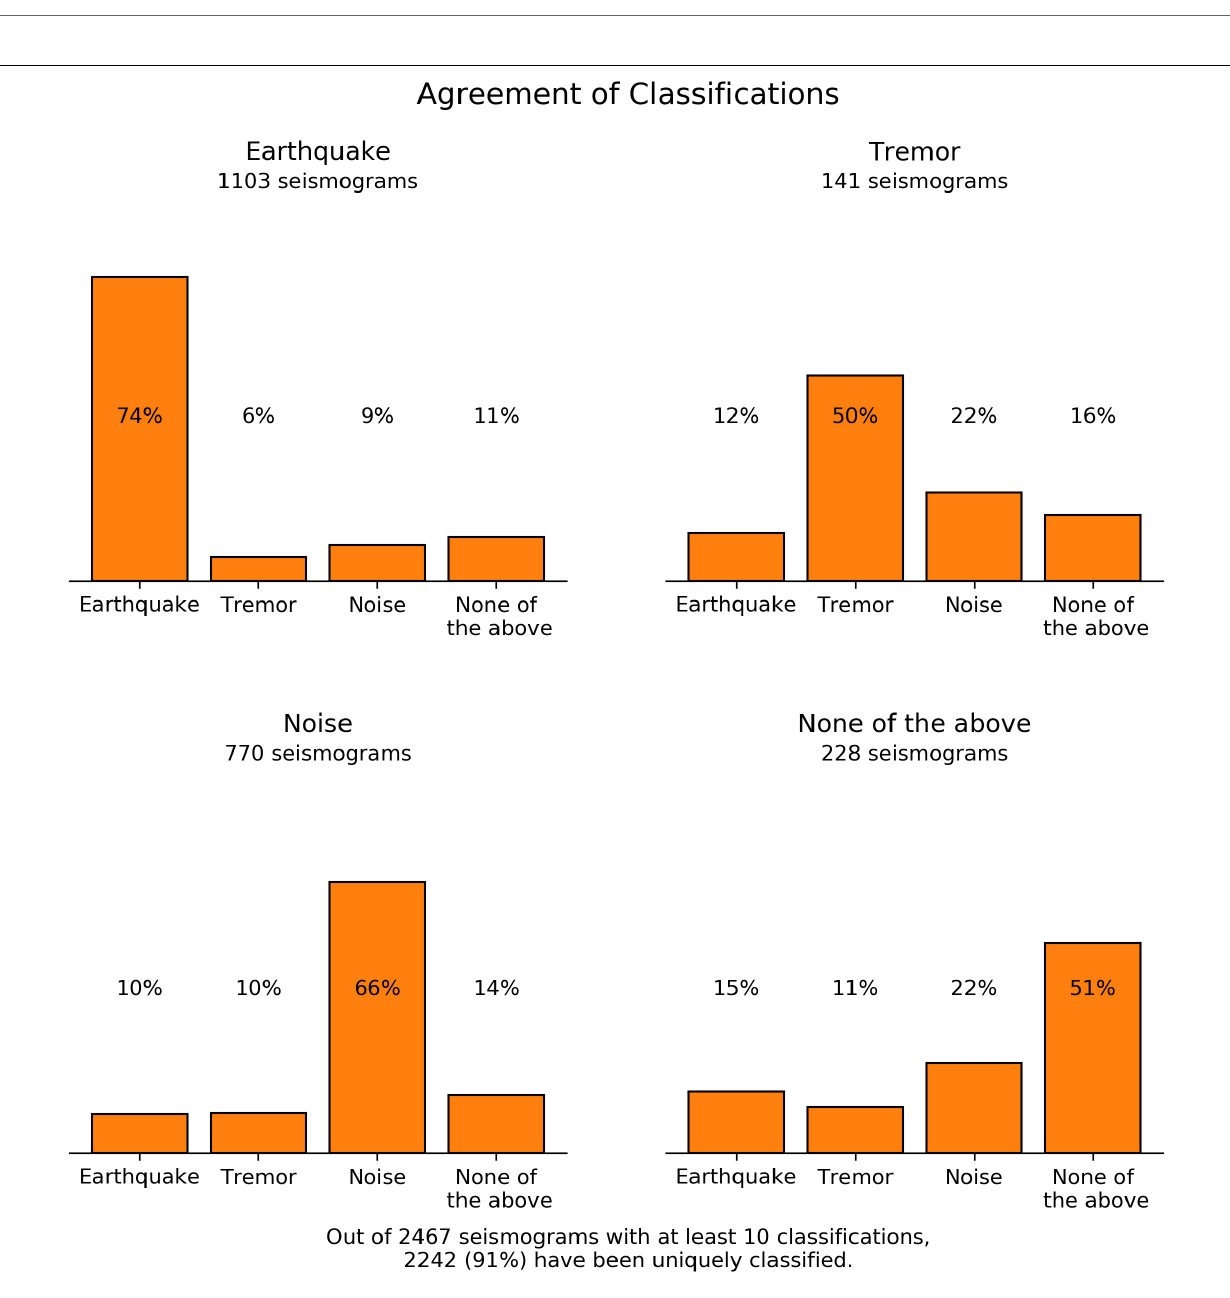
FIGURE 2 | Histograms for each classified category. The four categories contain seismograms which have received a majority classification for one category and show the average of the classifications made for the seismograms contained in this